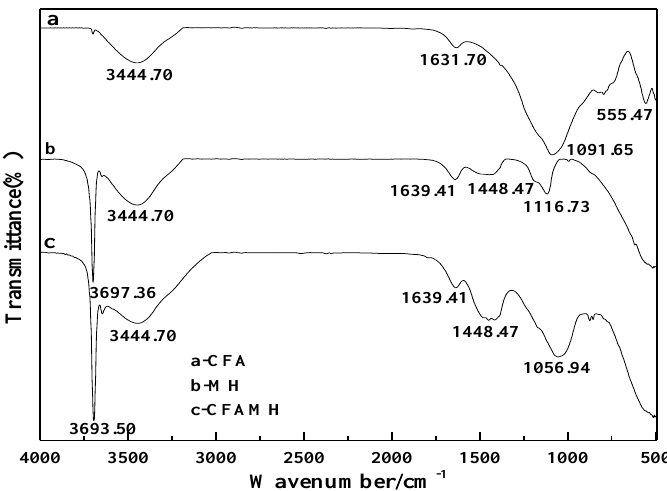
Figure 5. Fourier translation infrared spectroscopy (FTIR) spectra of CFA, MH and CFAMH.